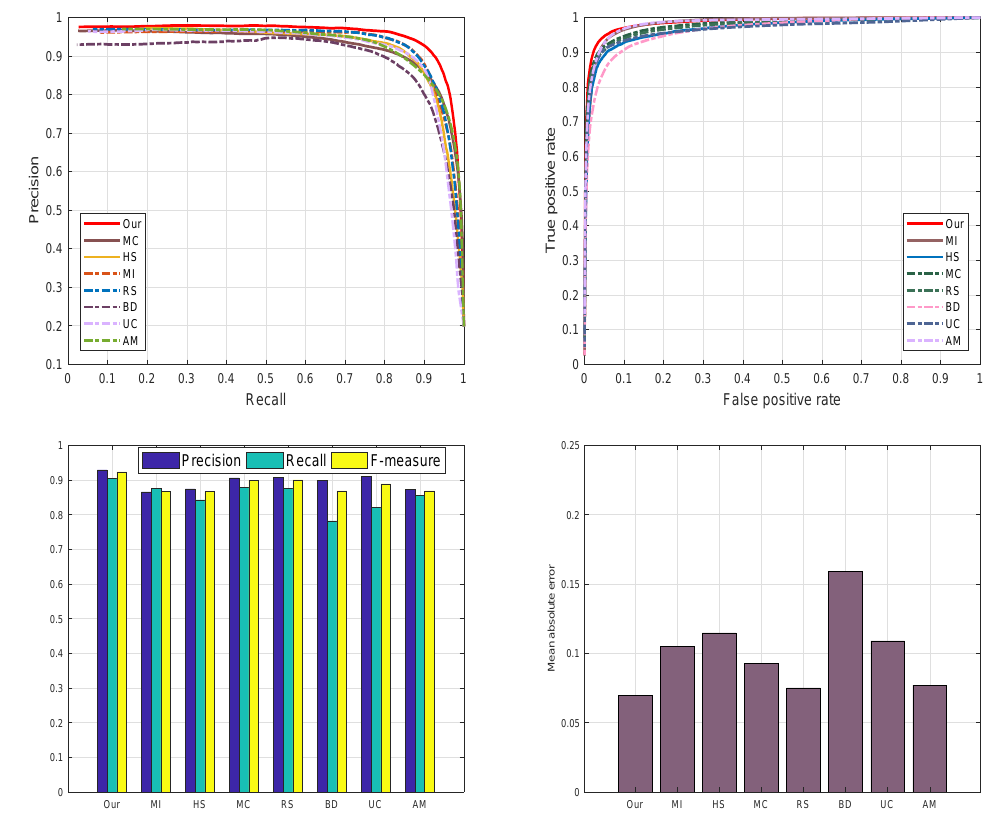
Figure 10. The graphical assessment of our model against seven current approaches AM [29], BD [42], RS [43], MC [44], MI [30], HS [39], UC [31] and our proposed model using the ASD